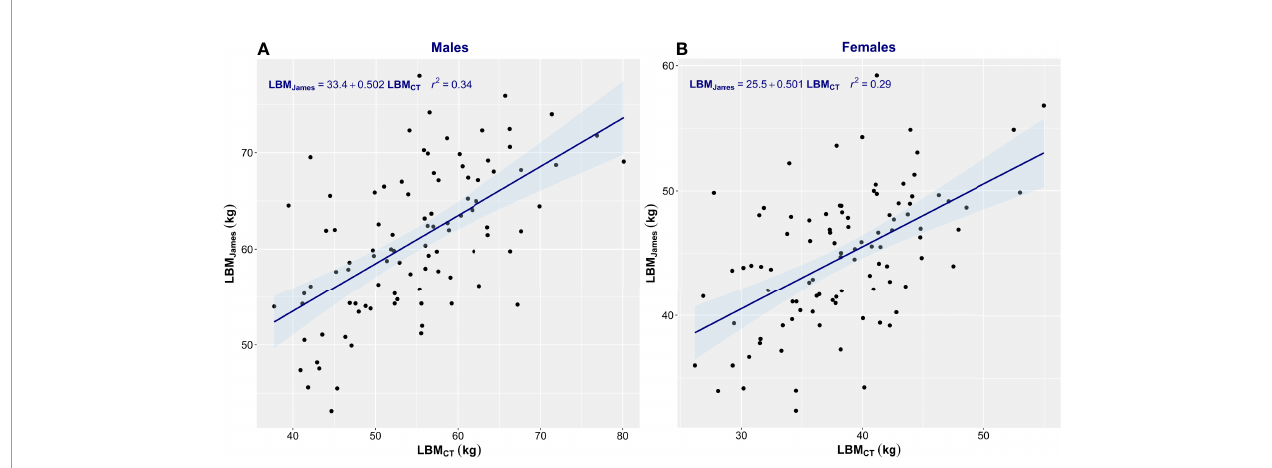
FIGURE 3 | Scatter plot of CT-de fi ned lean body mass (LBM CT ) vs. that estimated by James ’ equation (LBM James ). Men (A) and women (B) . The linear regression equation is provided in the top left of each graph, and it is plotted in blue. The shaded light-blue area represents the 95% con fi dence interval, and r 2 is the square of the Pearson correlation coef fi cient for LBM CT vs. LBM James